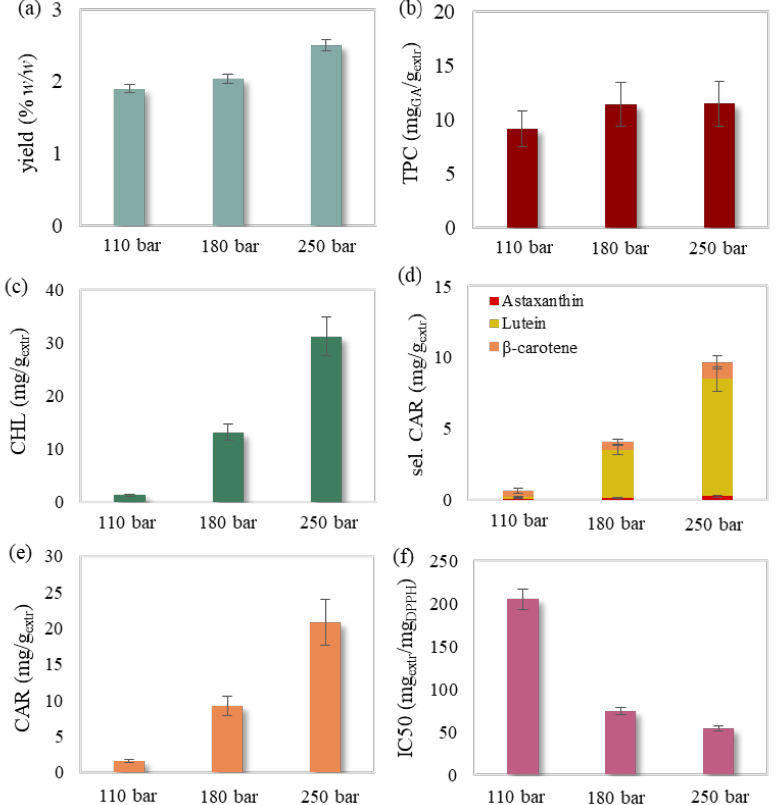
Figure 1. Pressure effect on SFE’s ( a ) yield, ( b ) total phenolic, ( c ) chlorophyll, ( d ) selected carotenoid, ( e ) total carotenoid content and ( f ) antioxidant activity examined at a temperature of 50 °C and a solvent flow rate of 30 g/min. The presented error bars express the standard deviation percentage of the central point replicates.